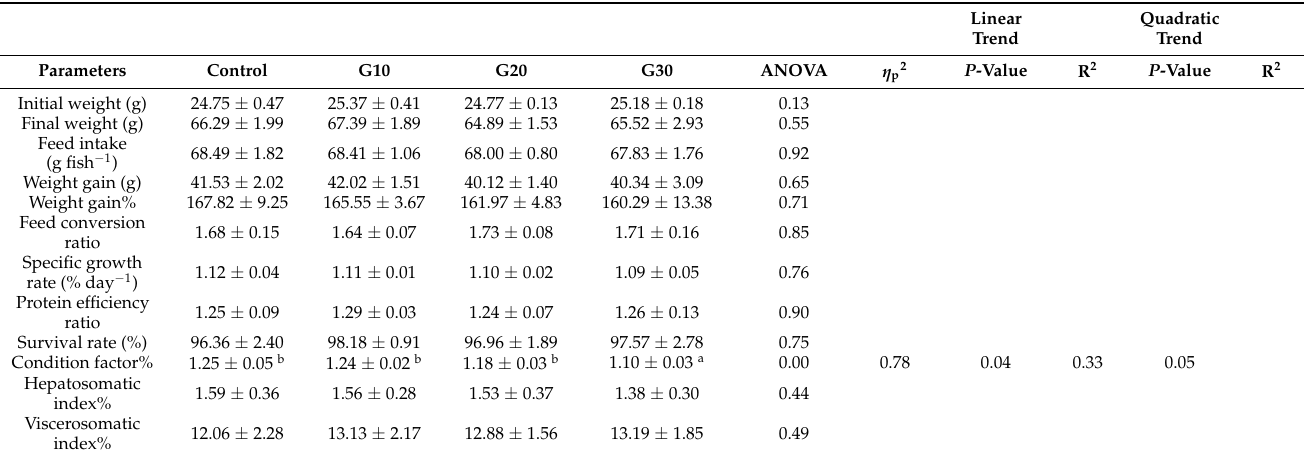
Table 2. Growth performance and feed utilization of juvenile Eurasian perch consuming feed supplemented with gar- lic powder.